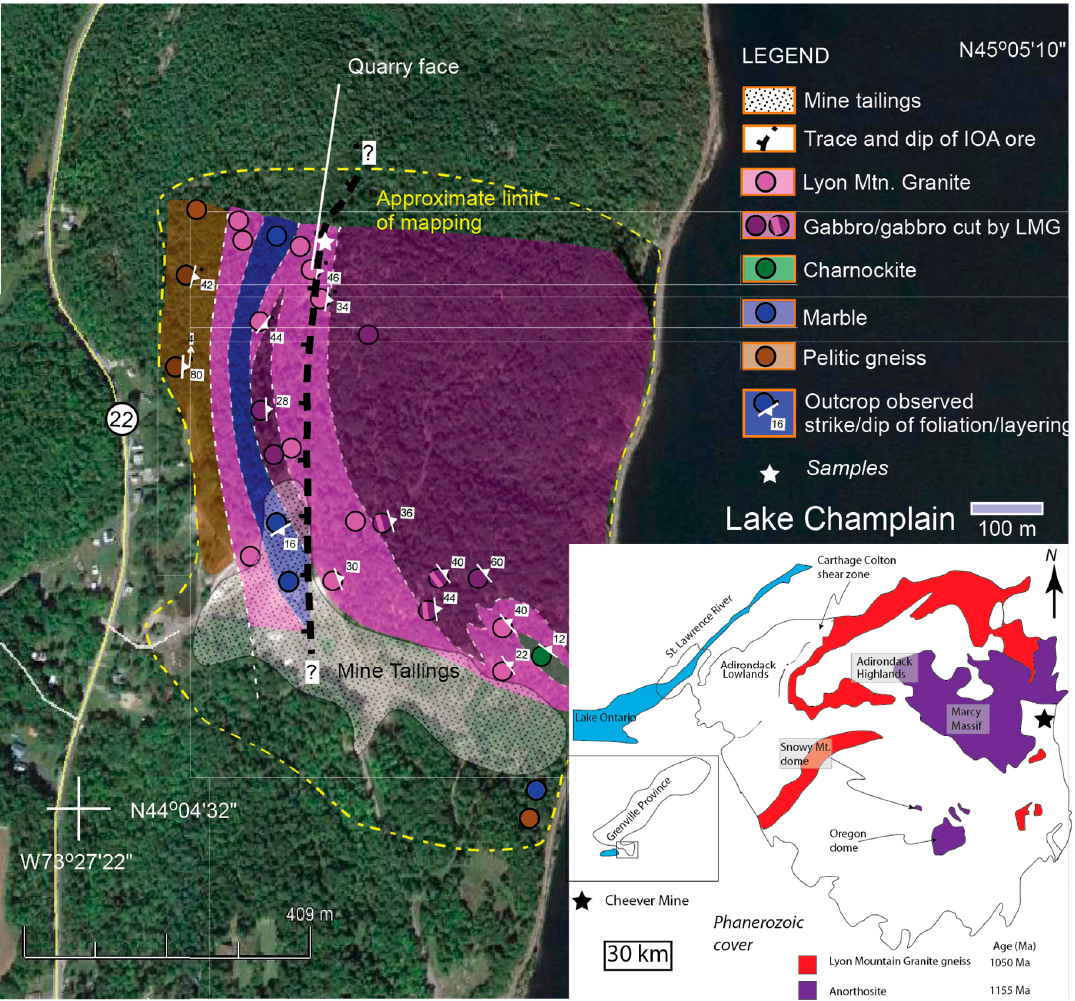
Figure 1. Detailed bedrock geology map from the Cheever Mine (modified from [11]). Inset: Simplified geologic map of the Adirondack region (modified after [11] and references therein) with the distribution of the Lyon Mountain Granite gneiss in red and inset displaying map relative to the Grenville Province and Lake Ontario. Star marks the sample. IOA: iron oxide-apatite; LMG: Lyon Mountain granite gneiss.